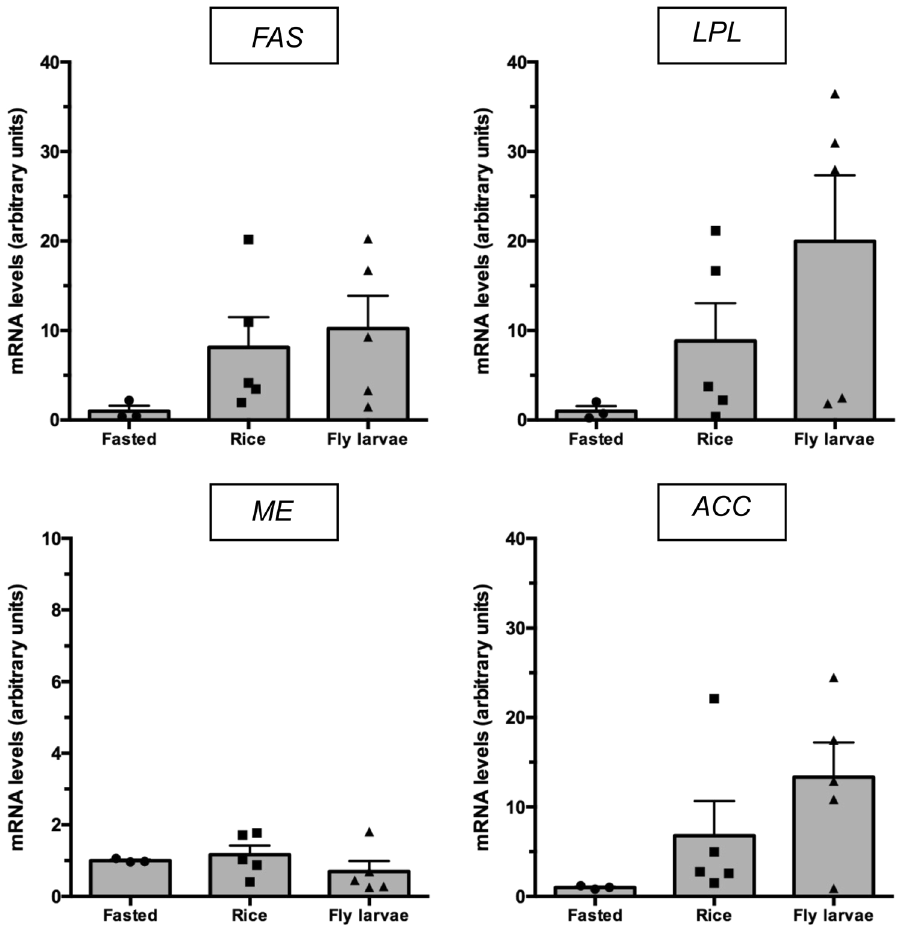
Figure 4. Fatty acid synthase ( FASN ), NADP-dependent malic enzyme ( ME1 ), acetyl-CoA carboxylase ( ACC ) and lipoprotein lipase (LPL) mRNA abundance in subcutaneous fat from black-tailed godwits submitted to three different diets (Fasted, Rice and Larvae). Values are presented as mean ± SEM (n = 3 for Fasted, n = 5 for Rice and Larvae). One-way ANOVA tested indicated no significant